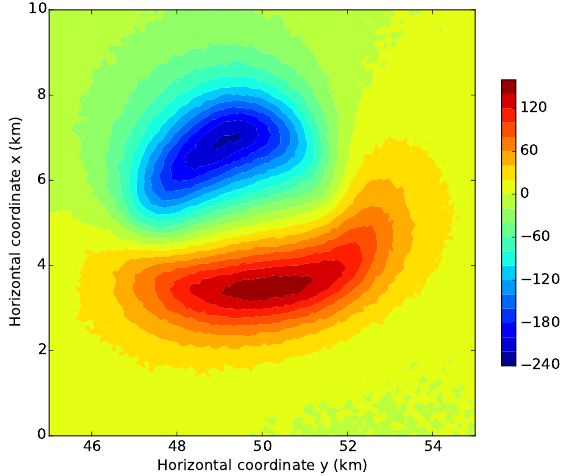
Figure 9. Strongly interfering anomalies. Noise-corrupted total- field anomaly produced by the synthetic bodies shown in Fig. 8. The data are in nT and were calculated on a plane with a constant vertical coordinate equal to − 10m. Figure 10. Igneous intrusion. 2-D schematic representation of a synthetic geologic setting composed of a non-magnetic sedimen- tary package (in grey), an igneous intrusion (in red) and a basement (in white). The sedimentary package and basement are semi-infinite along the x axis. The basement is magnetized by induction and the intrusion has a strong reversed magnetization. The plot has vertical exaggeration.